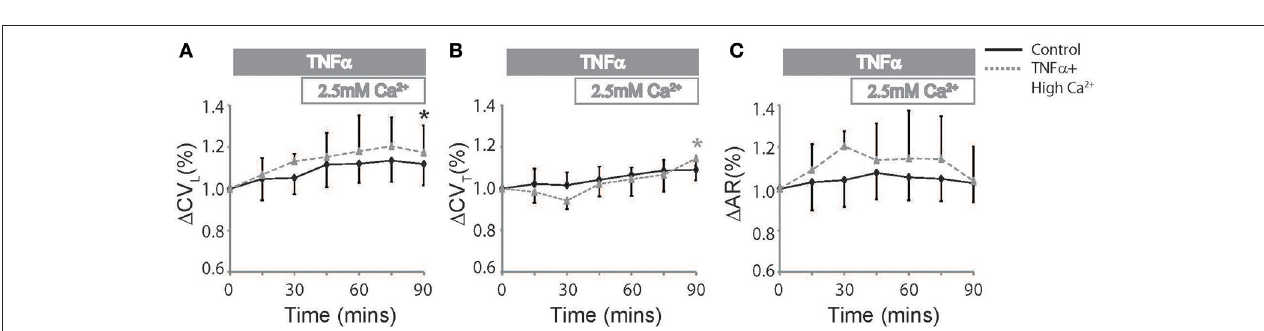
FIGURE 2 | TNF α slows conduction. (A) Representative isochrones maps from control and TNF α perfused hearts at t = 0 and 90mins. (B) Summary of CV L , CV T, and AR values calculated from the optical recordings are graphed. Black and gray *Indicates p < 0.05 between t = 0 and 90mins in control and TNF α perfused hearts respectively by paired comparison. # Indicates p < 0.05 between control and TNF α (unpaired).